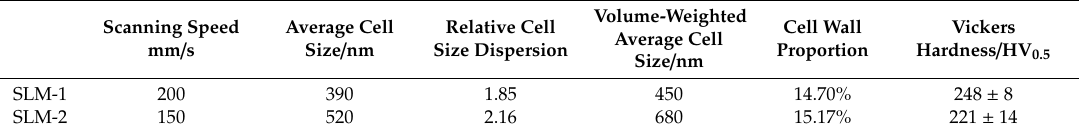
Table 2. Average cell size, relative cell size dispersion, volume-weighted average cell size of equiaxed cells, and Vickers hardness of SLM CrFeNiMn alloy